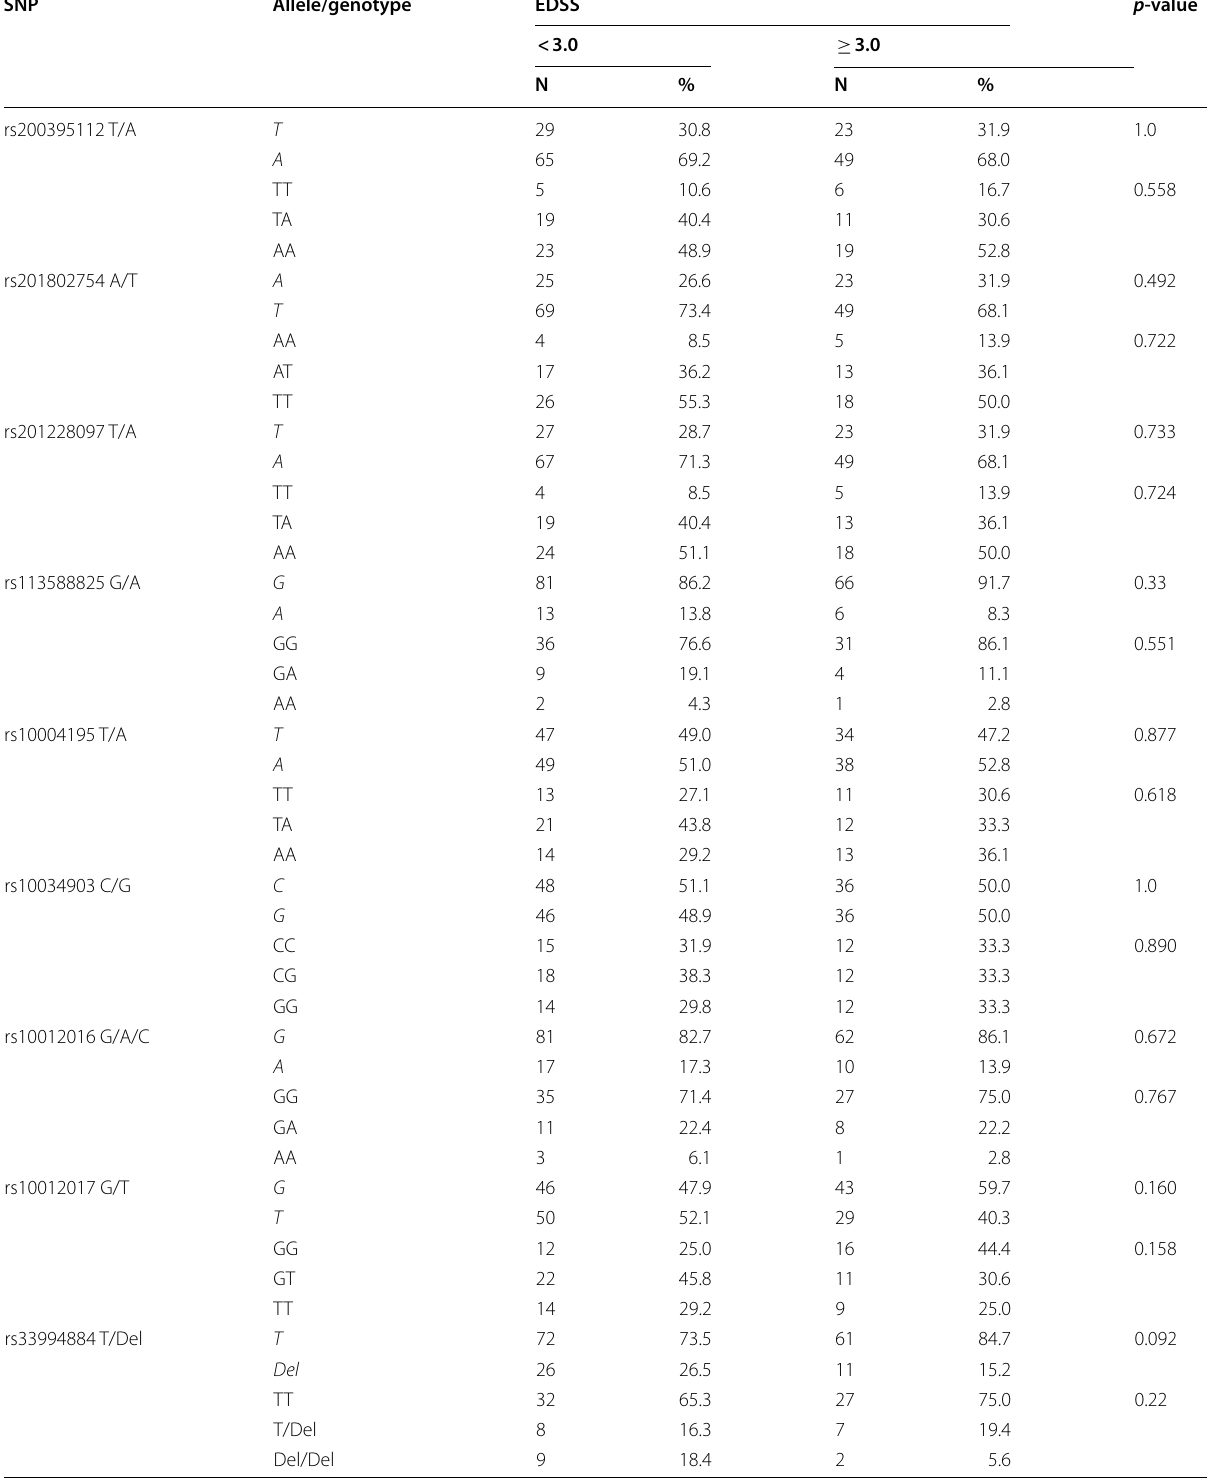
Table 2 Allele and genotype frequencies of TLR10 gene SNPs stratified by Expanded Disability Status Scale groups in multiple sclerosis patients